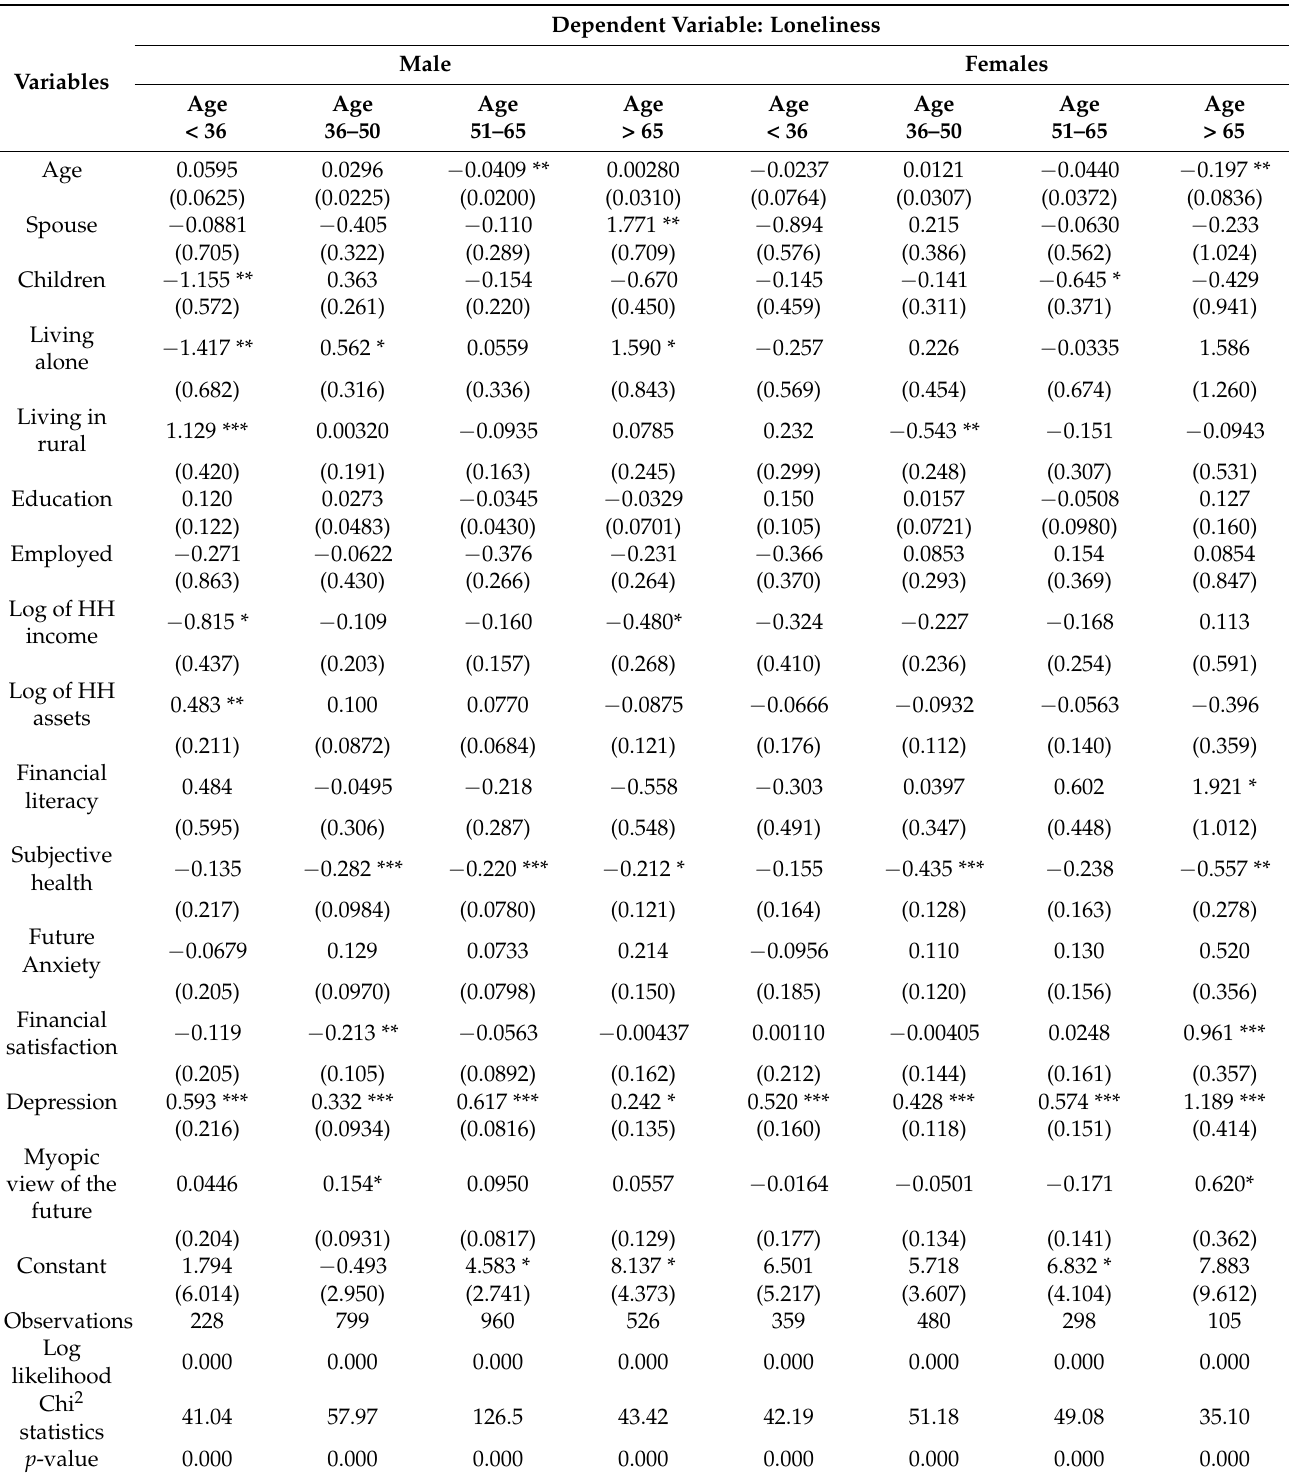
Table 6. Logit regression results of loneliness in 2021 (subsample analysis: gender and age